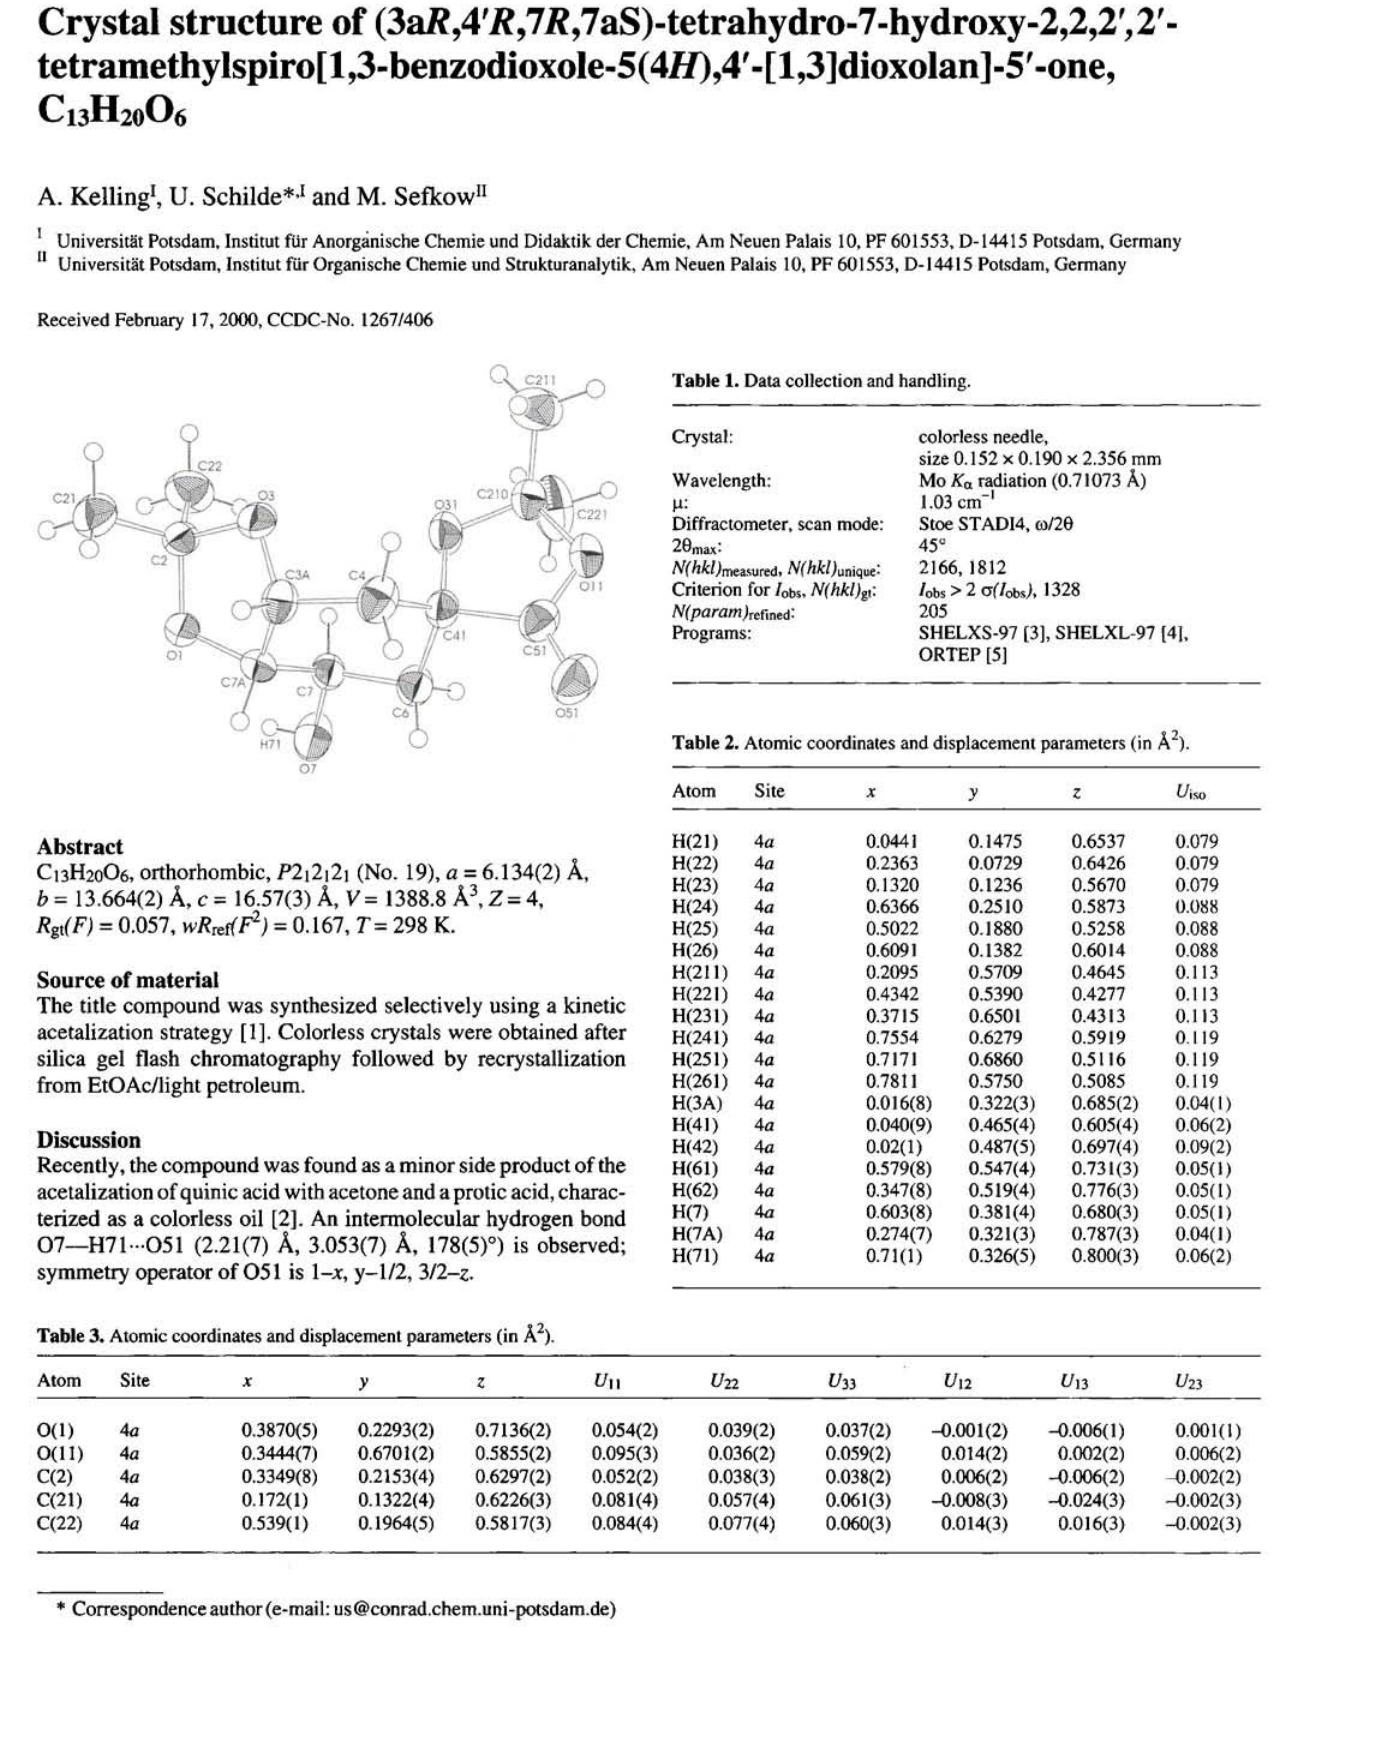
Table 3. Atomic coordinates and displacement parameters (in Ä 2